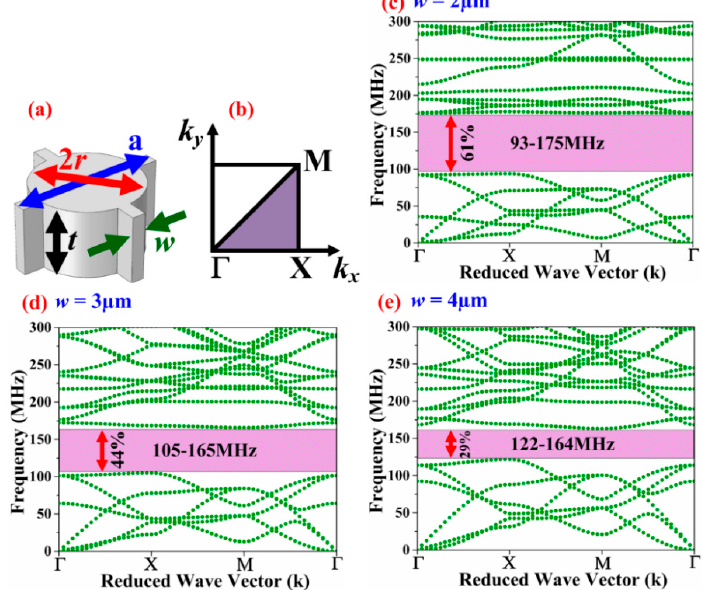
Figure 1. ( a ) Perspective view of solid disk PnC basic unit cell; ( b ) 1st irreducible Brillouin zone in k-space, frequency band diagrams by finite element (FE) analysis of a solid disk PnC for various inter-cell link widths of ( c ) w = 2 μ m ( d ) w = 3 μ m ( e ) w = 4 μ m. Figures modified from